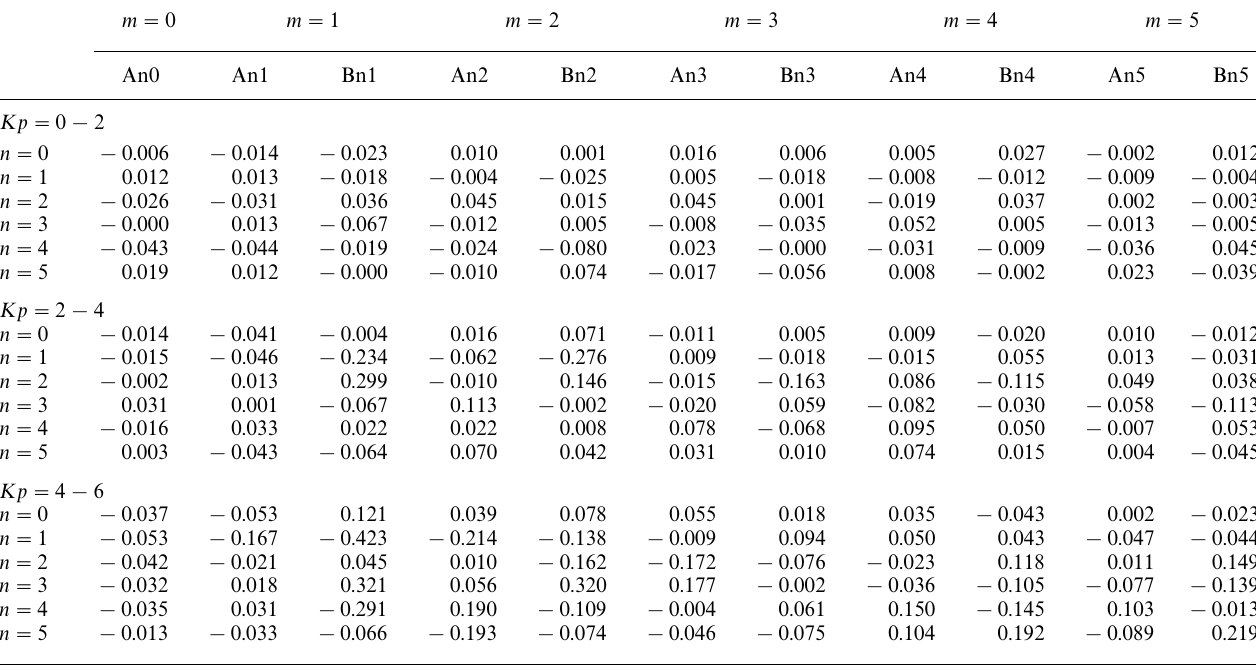
Table 1. Coefficients of the polynomial expansion for the model of the field-aligned currents